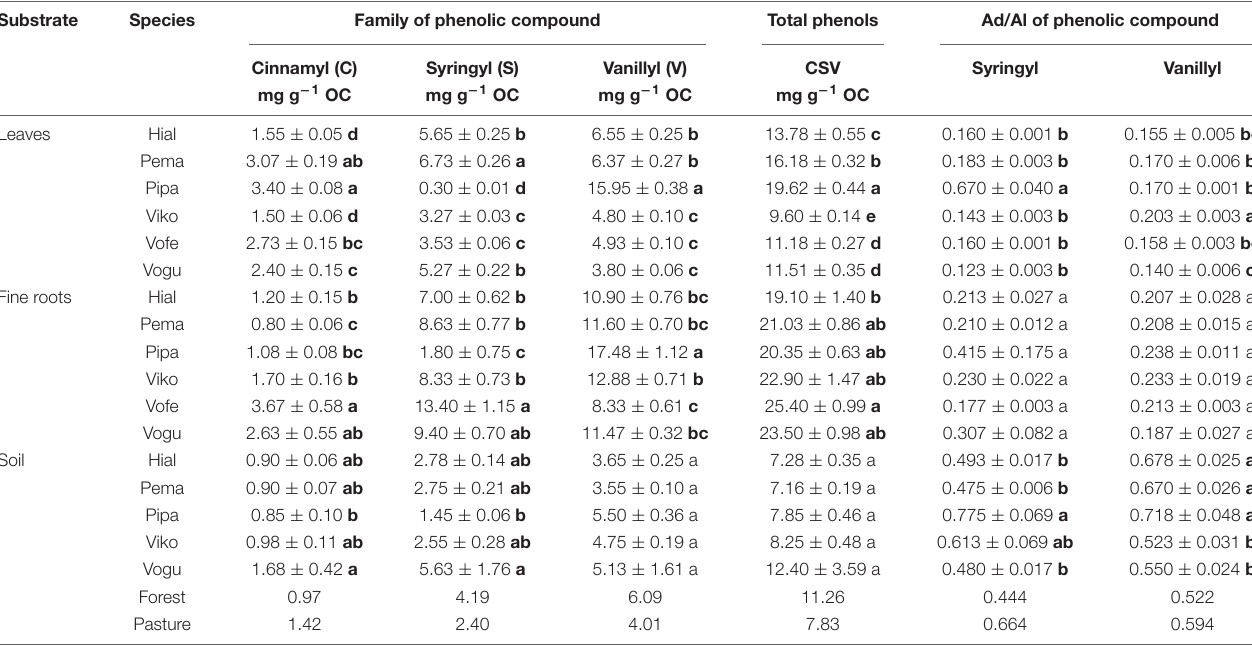
TABLE 1 | Phenolic compounds and their Acid/aldehyde (Ad/Al) ratios in six tropical tree species in 15-year-old plantations. Substrate Species